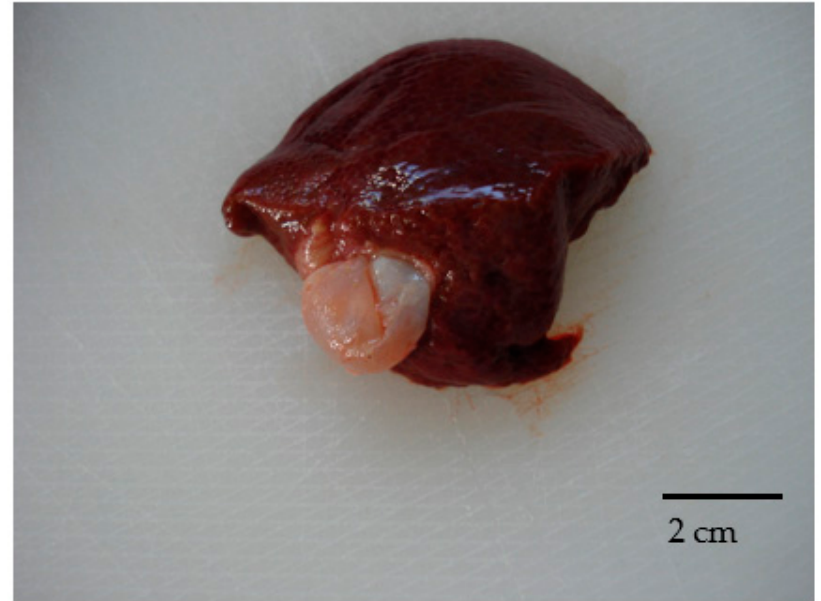
Figure 1. Hepatic cystic lesions.